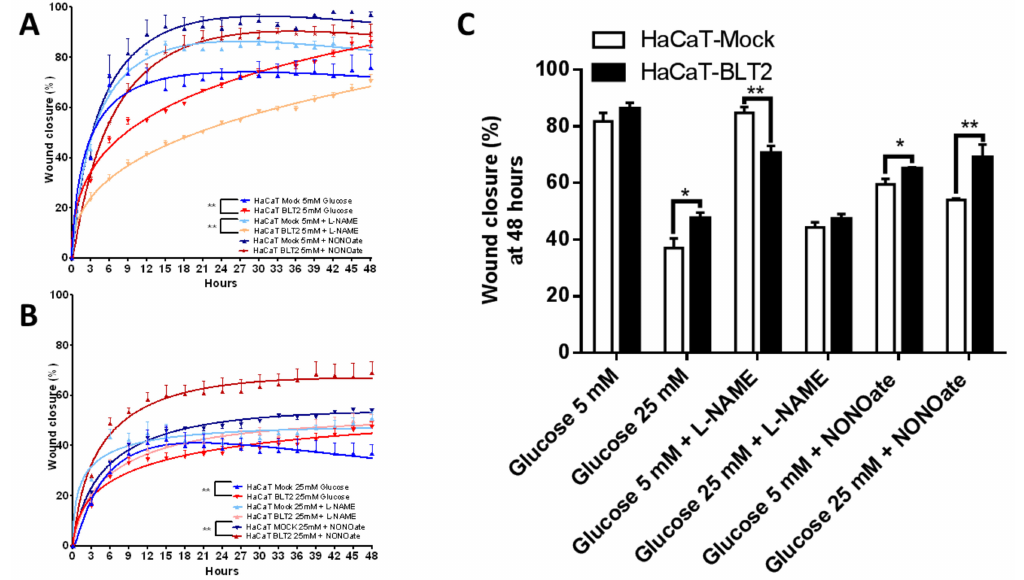
Figure 5. The inhibition of NOS or NO donation a ff ects selectively to the BLT2 expressing cells. Wound healing assay, using the unspecific NOS inhibitor L-NAME at 100 µ M or a NO donor at 100 µ M for 48 h. ( A ) Quantification under low glucose (5 mM); or ( B ) quantification under high glucose (25 mM) for two days with measurements every 3 h. ( C ) Wound healing percentage after 48 h. Data represent mean ± SEM, of n = 3 independent experiments. * p < 0.05, ** p < 0.01, one-way non-parametric ANOVA (Kruskal–Wallis